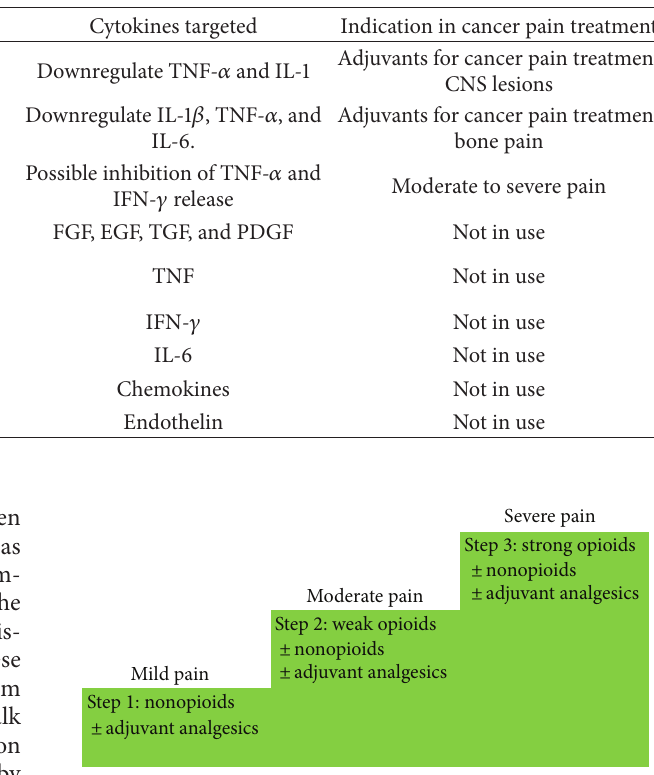
Table 1: Drugs targeting cytokines that have been tested in pain control.